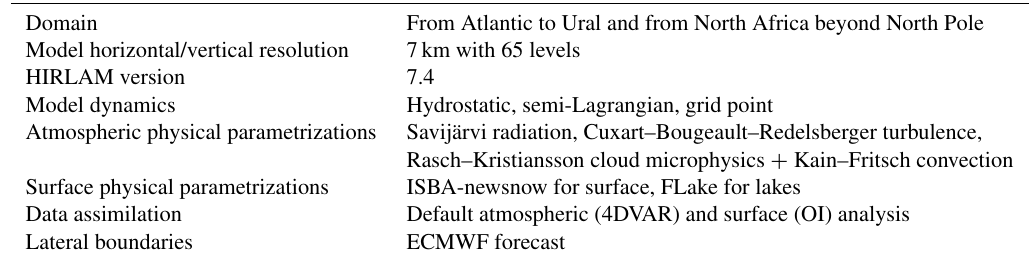
Table 1. FMI operational